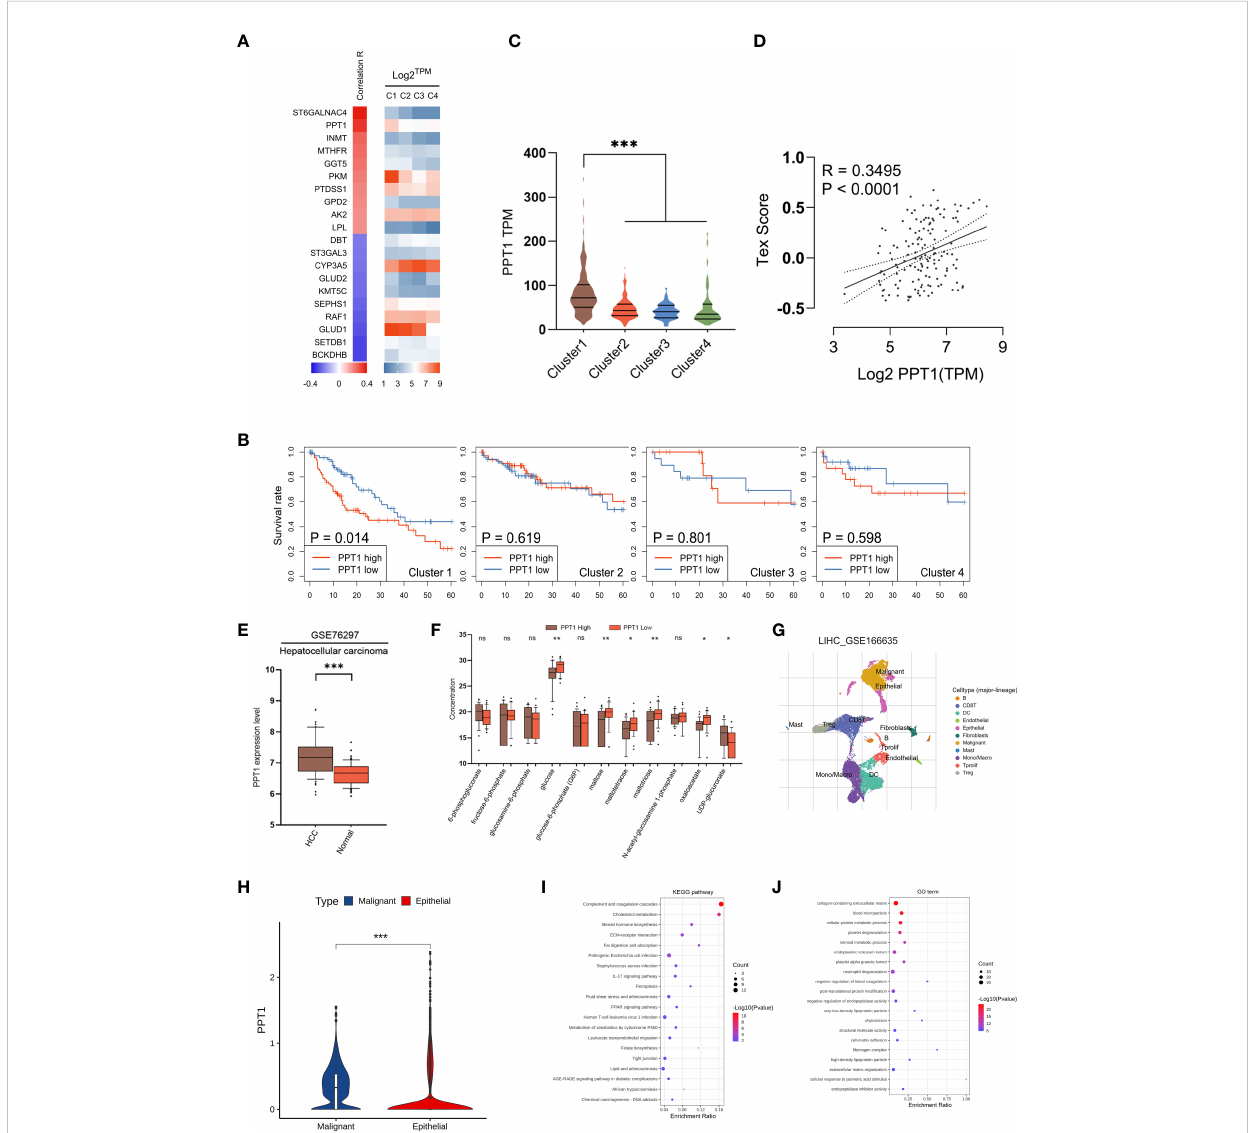
FIGURE 7 Identi fi cation of PPT1 as a therapy target. (A) Heatmap showing the correlation between prognostic metabolic genes and Tex score. The top 10 most positively/negatively correlated genes are shown. (B) Survival curves showing the distinctive prognostic value of PPT1 in different metabolic subtypes. (C) Violin plots showing the expression of PPT1 in samples of different subtypes. (D) Scatter plot depicting the correlation between PPT1 gene expression and Tex score. (E) PPT1 expression in HCC and non-tumorous tissues was analyzed using data in the LIHC_GSE76297. (F) Box plots depicting the glycolytic related metabolites between low and high PPT1 expression subgroup. (G) Single-cell RNA sequencing revealed the cell types and distribution of HCC. (H) Violin plots showing the PPT1 expression between malignant and epithelial cells. (I, J) The KEGG pathways (I) and GO biological processes (J) enrichment analysis of PPT1 in malignant cells. (ns: not signi fi cant, *: P < 0.05, **: P < 0.01, ***: P <